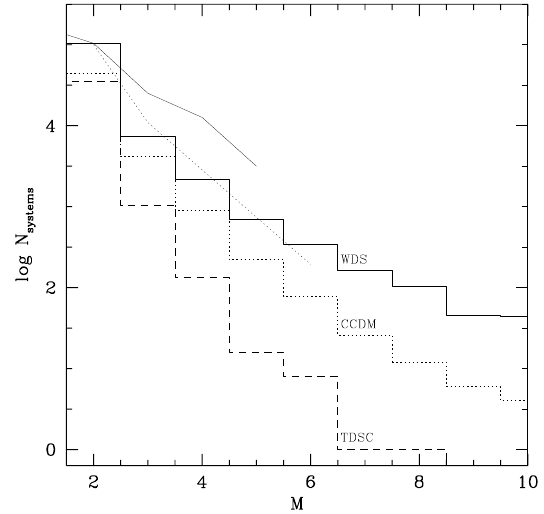
Fig. 1. Observational distribution of stellar systems on multiplicity M . The his- tograms represent the distributions from principal catalogues of double and multiple stars: WDS (solid), CCDM (dotted), TDSC (dashed). The curves represent published statistics on hierarchical stellar systems; dotted curve: Orlov & Titov (1994) and Tokovinin (2001); solid curve: Tokovinin (2014). The curves are normalized on the number of binaries in